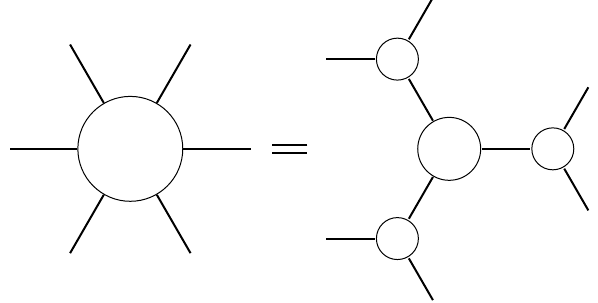
Figure 5: Shown is a rank-6 tensor (left) along with its factorization into a tensor tree